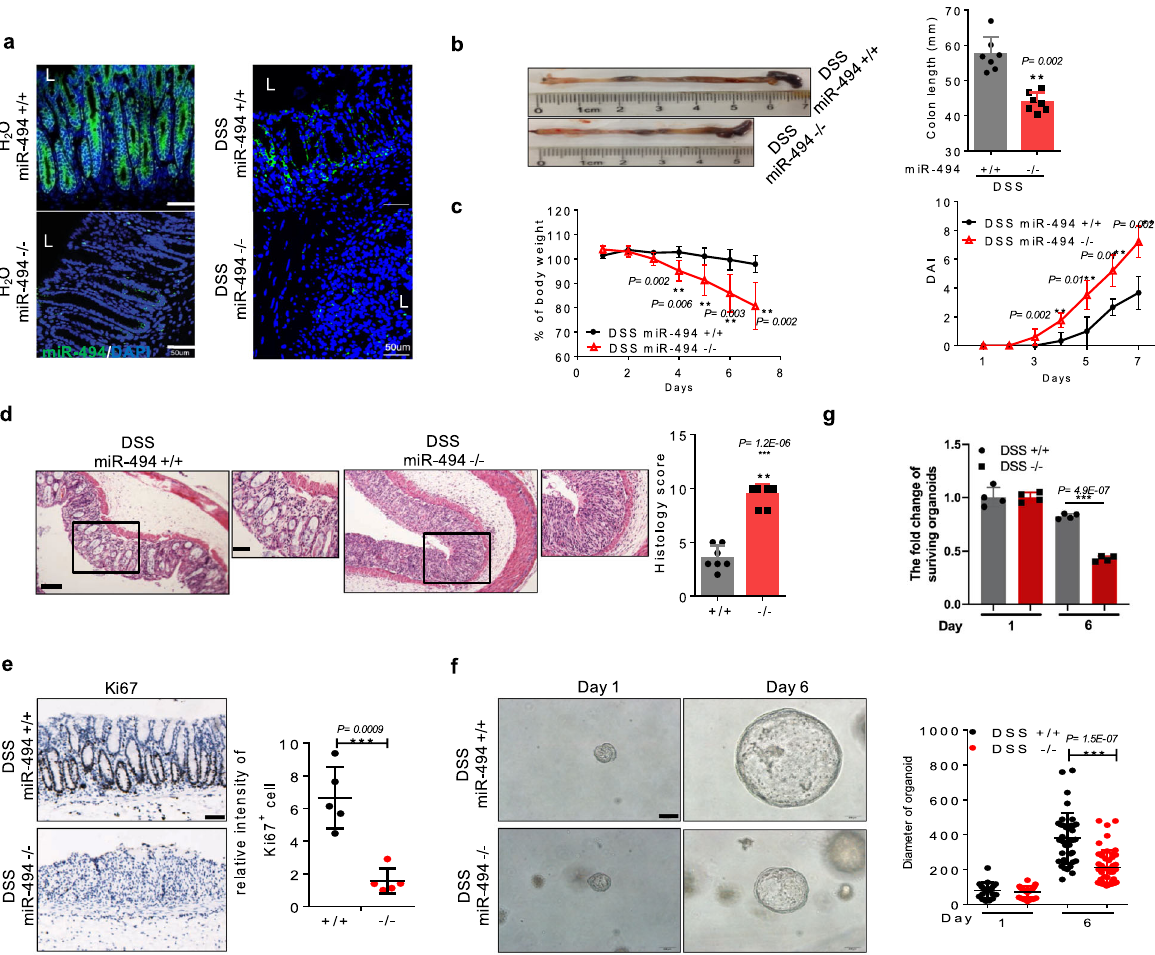
Fig. 2 miR-494 − / − mice exhibit abnormalities in crypt stem cell identity in DSS-induced colitis. a – g miR-494 knockout mice ( miR-494 − / − , − / − ) and wide-type mice (WT, miR-494 + / + , + / + ) at 8-weeks old were provided with free access to drinking water with 3% DSS for 7 days. Day 0 is the initiation of DSS treatment. a Representative images of miR-494-3p expression in colon tissue from RNA-FISH assay, scale bar: 50 μ m. b Typical images of the colon from miR-494 − / − mice and WT mice on day 7. Colon length was measured on day 7 after killing. c Body weight changes and DAI. d Hematoxylin and eosin (H&E) images of colon tissue and histology score (0 – 12), scale bar: 200 μ m. The scale bar of close-up image is 100 μ m. e IHC was performed for the proliferation marker Ki67 in colon, scale bar: 100 μ m. f Representative images of colon organoids derived from colonic crypt that were isolated from DSS- treated mice (on day 7) and then cultured in vitro for 6 days (right), scale bar: 100 μ m. e , f The diameter of organoids and number of Ki67 + cells were measured by ImageJ. g The quanti fi cation of surviving organoids. Scale bar: 100 μ m. Data are presented as mean ± S.D. and analyzed by non-paired